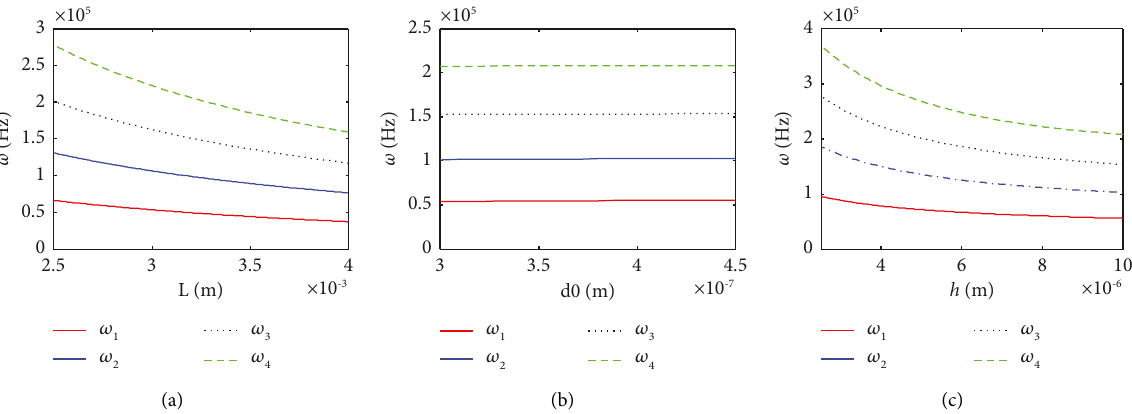
Figure 9: Changes of the resonant frequencies with system parameters (even modes) (a) length changes (b) clearance changes (c) thickness